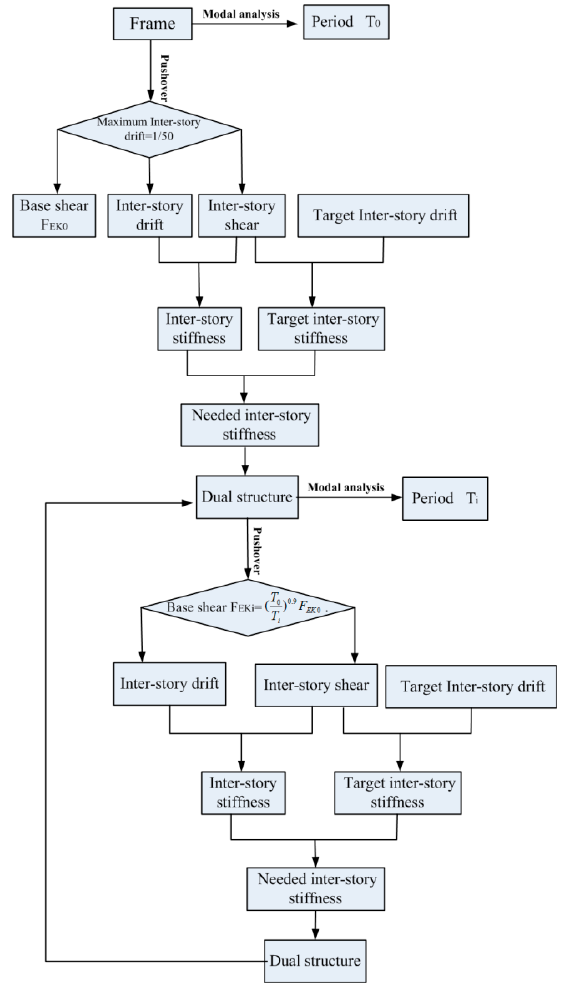
Figure 15. Design procedure of dual structural system.